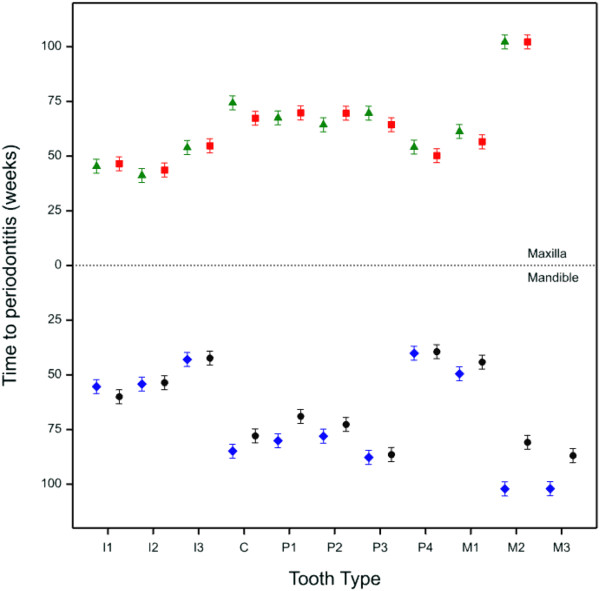
Estimated time for each tooth to progress to early stage periodontitis. Green triangles and blue diamonds = right-hand side of the mouth; red squares and black circles = left hand side of the mouth. Error bars signify 95% confidence intervals.